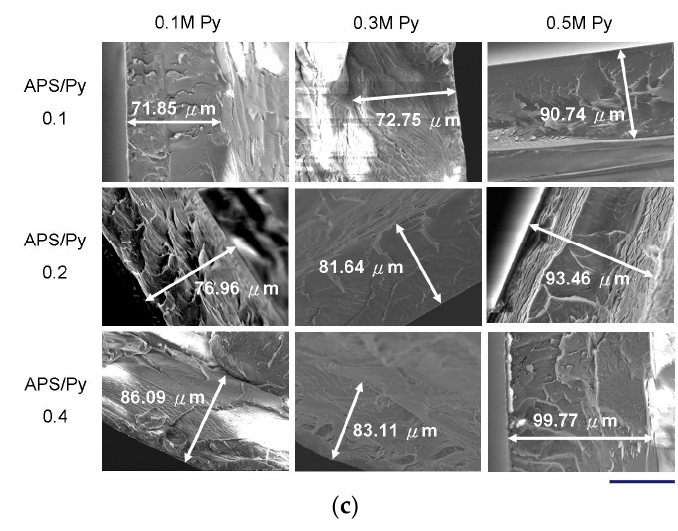
Figure 1. The fabricated polypyrrole (PPy) films: ( a ) PPy films were fabricated by different concentrations of pyrrole and APS/Py ratios; ( b ) surface roughness of PPy films by SEM (Scale bar = 10 µ m); and ( c ) cross sections SEM of PPy films (Scale bar = 50 µ m).